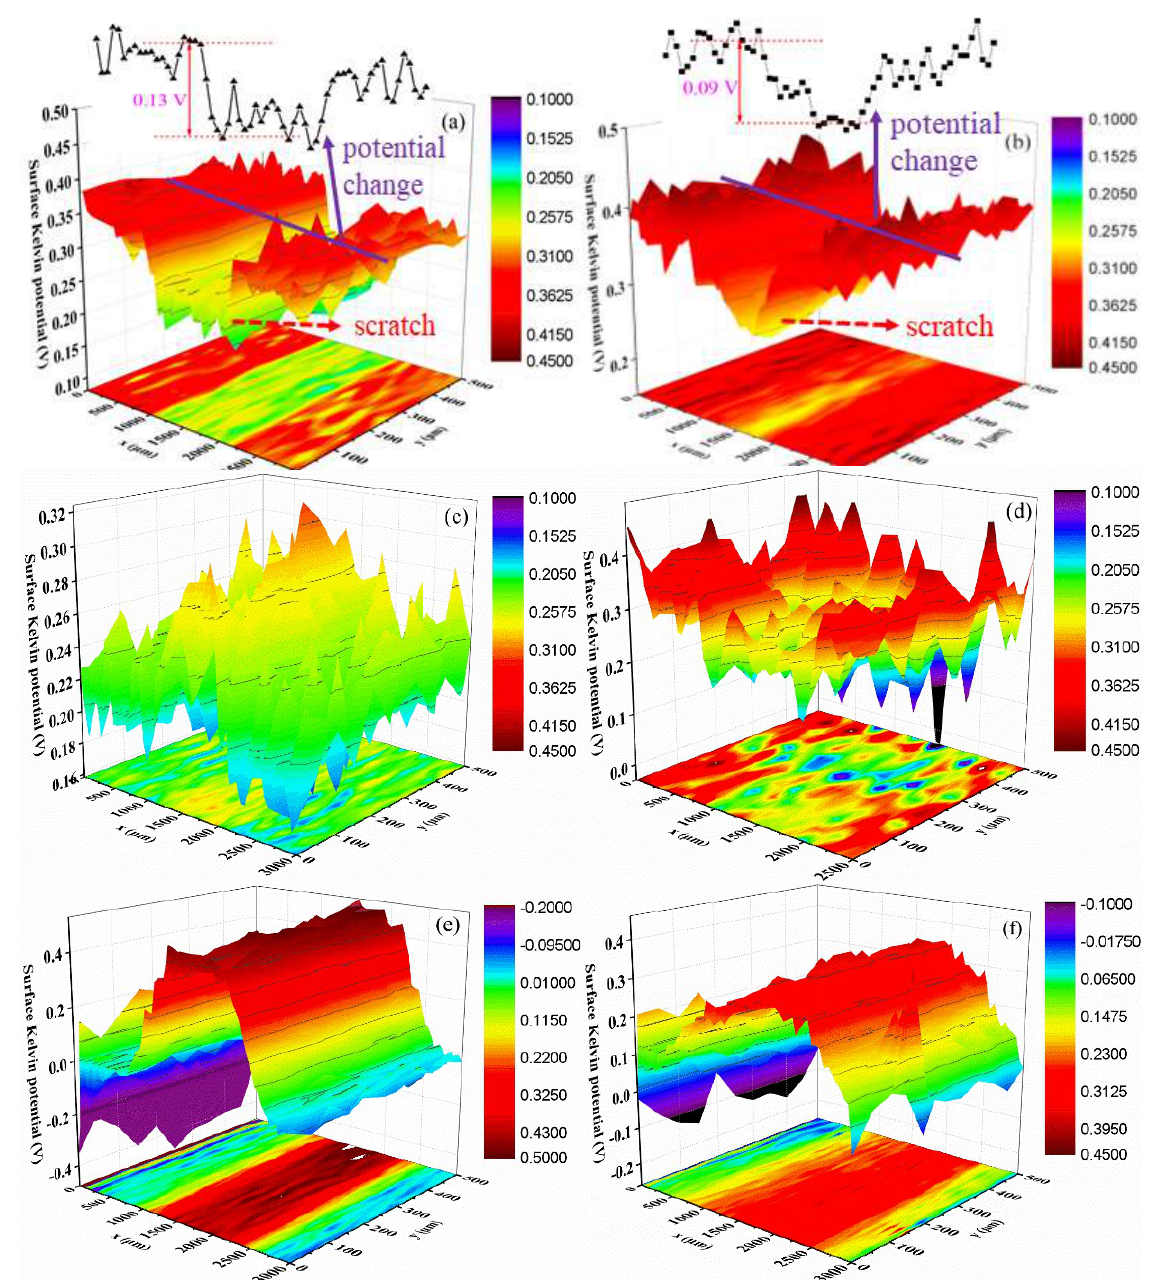
Figure 9. Surface Kelvin potential mapping of samples after salt spray tests with different periods, ( a ) 0%, 0 d; ( b ) 2 wt %, 0 d; ( c ) 0%, 3 d; ( d ) 2 wt %, 3 d; ( e ) 0%, 10 d; ( f ) 2 wt %, 10 d.